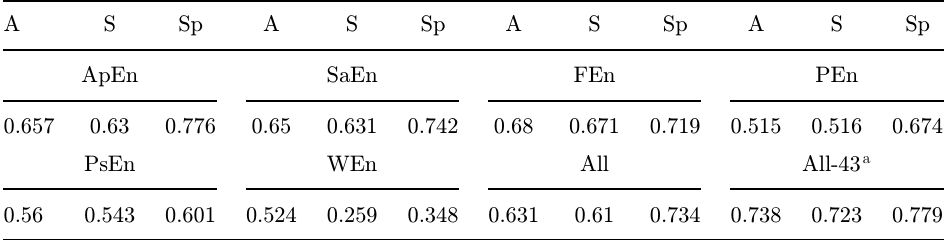
Table 3. Performance values of per feature set, Columns labeled \A, S and Sp" corresponding to accuracy, sensitivity and speci¯city, respectively.